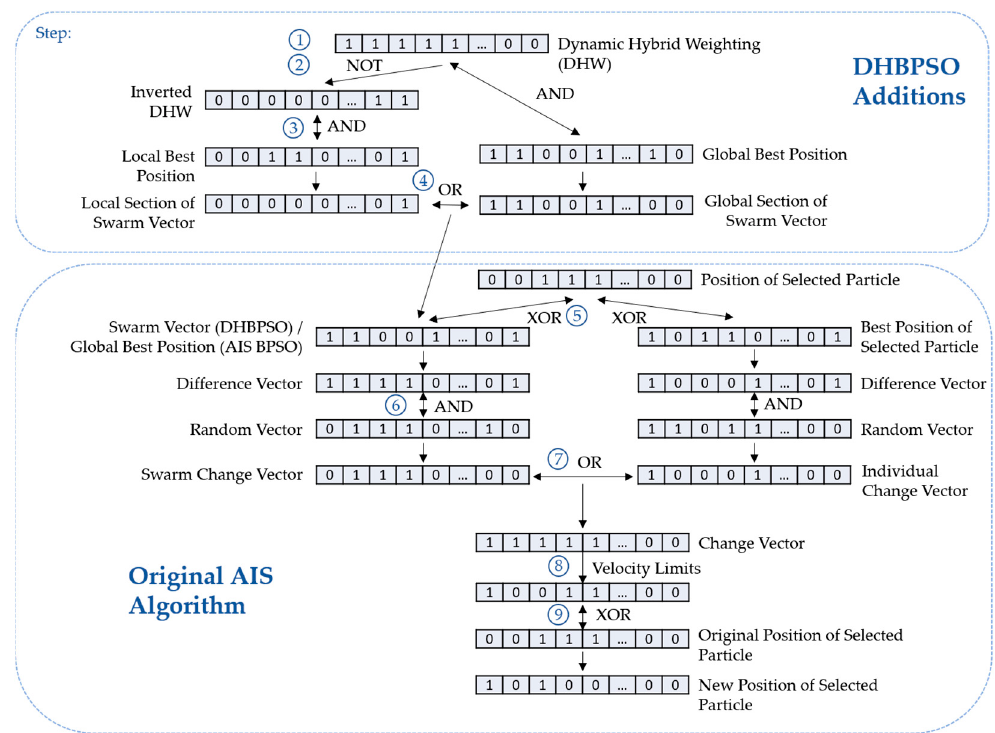
Figure 1. The proposed Dynamic Hybrid Binary Particle Swarm Optimization (DH-BPSO) algorithm to update each particle’s position every iteration.